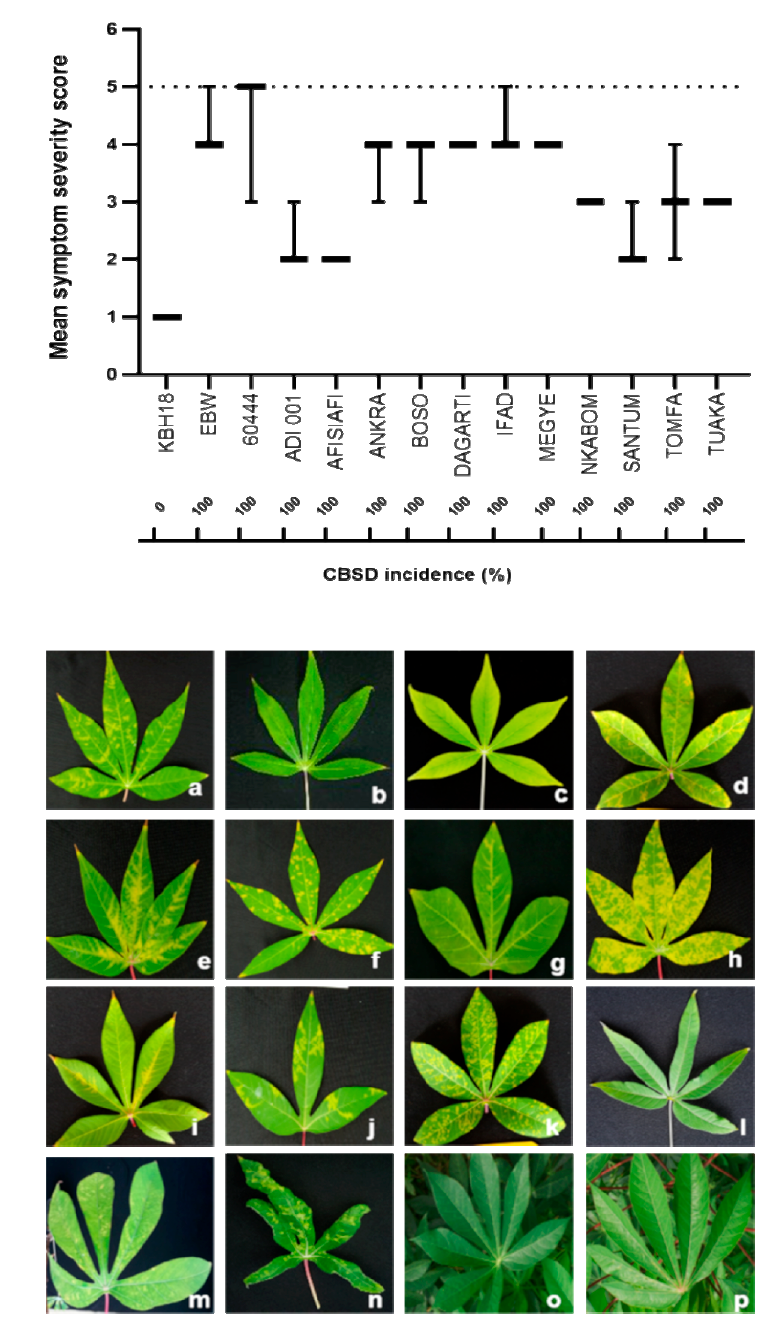
Figure 1. Cassava brown streak disease (CBSD) incidence, severity and symptom expression in leaves of Ghanaian cassava cultivars at 12 weeks post grafting. ( A ) CBSD incidence and mean symptom severity scores in Ghanaian cassava genotypes. ( B ) CBSD symptom expression in leaves of (a) Dagarti (b) Santum (c) Afisiafi (d) Bosomnsia (e) IFAD (f) Megyewontem (g) Tomfa (h) Ankra (i) ADI 001 (j) Nkabom (k) Tuaka (l) KBH 2006 / 18 (m) Ebwanateraka and (n) 60444. No symptoms were found in non-infected leaves of (o) Tuaka and (p) Ankra. CBSD incidence and mean symptom severity scores are based on three biological replicates for each cultivar. CBSD symptom expression in leaves of Ghanaian cassava cultivars was assessed using a 5-point scoring scale where 1 = no visible CBSD symptoms and 5 = severe foliar symptoms and plant die-back [40–42].